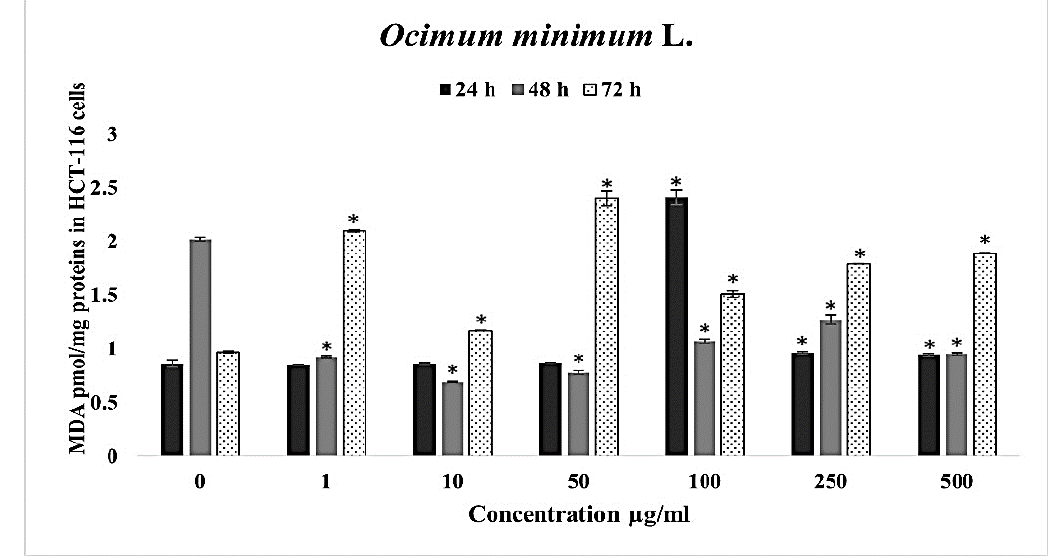
Figure 4. The concentration of MDA, presented in pmol/mg of protein in HCT-116 colorectal carcinoma cells after 24, 48, and 72 h of O. minimum treatment. The results are presented as the mean of two independent experiments ± standard error. *Statistically significant difference (p<0.05) compared to control